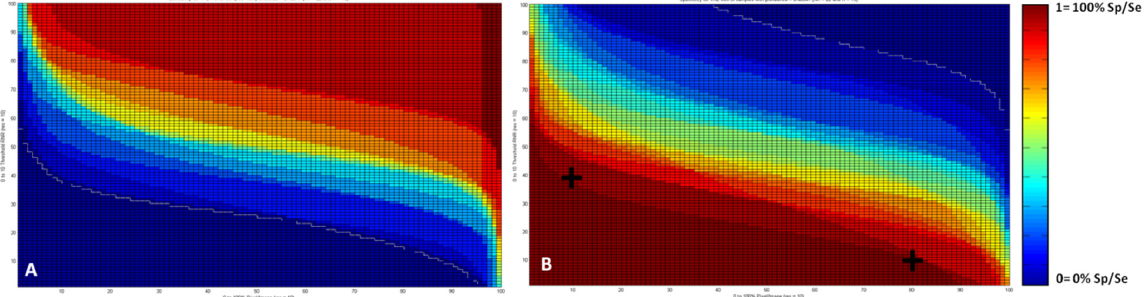
Figure 3. 2D map of sensitivity ( A ) and specificity ( B ) for test set according to the values of percentage of pixels ( x axis) and R/NR PLS score ( y axis).